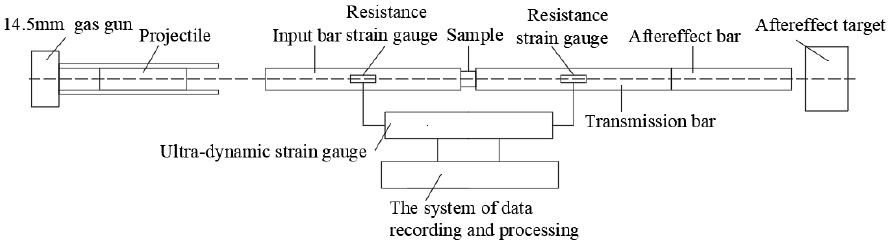
Figure 3. The schematic diagram of the dynamic compression test layout.